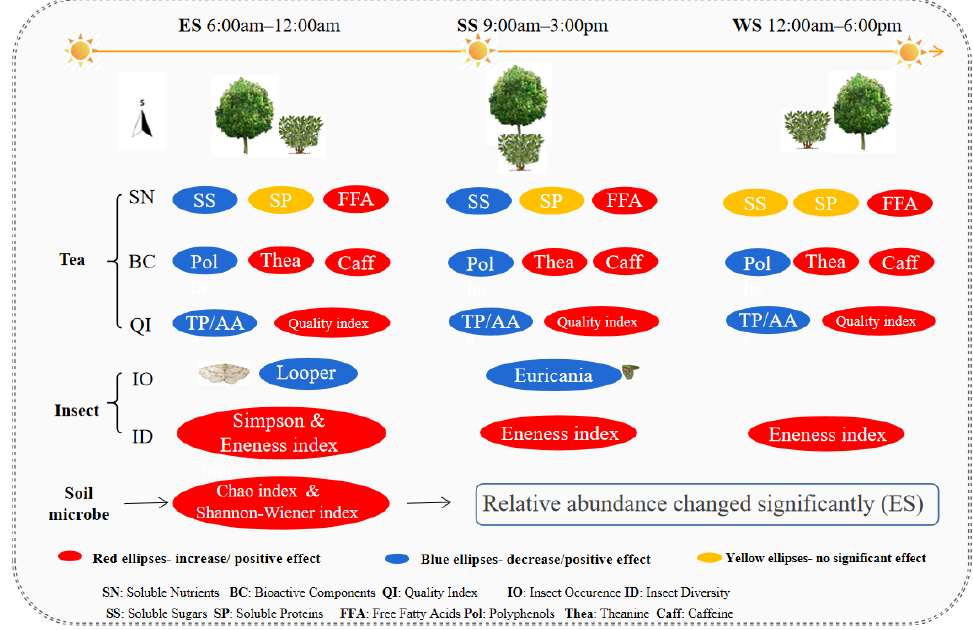
Figure 8. Effects of ecological shading of roadside trees on the soluble nutrients and bioactive components, community diversity of insects, and the soil microbes, as well as on the tea.